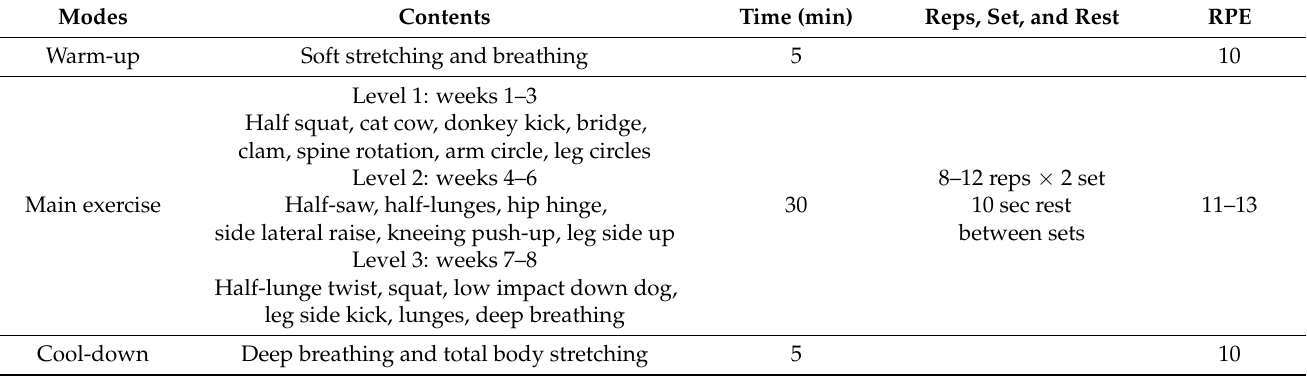
Figure 1. Experimental design. EPDS: Edinburgh Postnatal Depression Scale, PSQI: Pittsburgh Sleep Quality Index, PSS: Perceived Stress Scale, HRmax: maximal heart rate, RPE: rating of perceived exertion. Table 1. Online Pilates program.